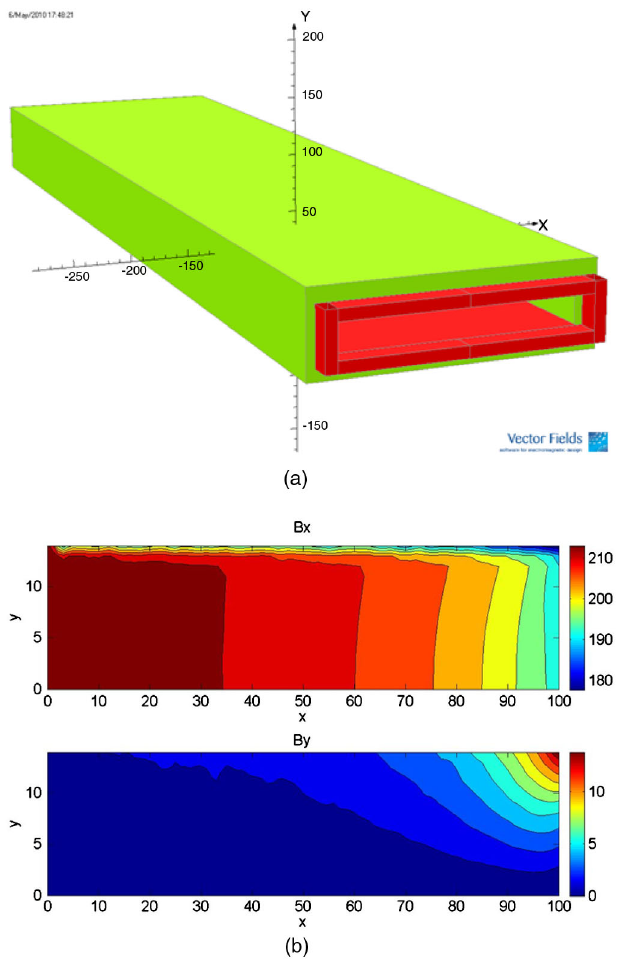
FIG. 35. (a) 3D kicker model in OPERA and (b) integrated horizontal and vertical magnetic field in the